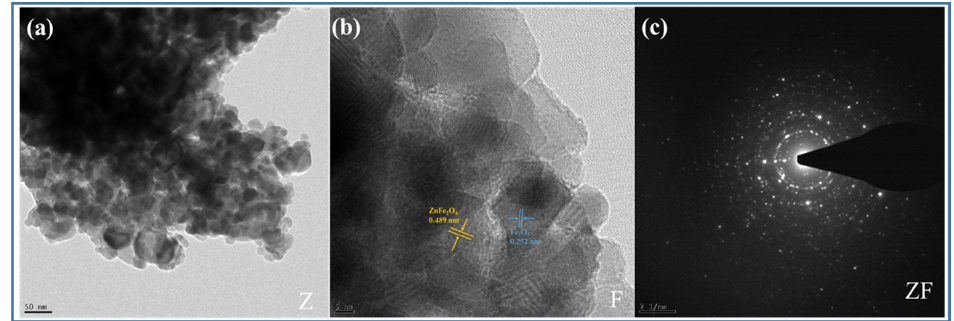
Figure 4. High resolution morphology images of ZnFe 2 O 4 -Fe 2 O 3 (ZF) nanostructures. The optical bandgap of the synthesized ZnFe 2 O 4 (Z), Fe 2 O 3 (F), and ZnFe 2 O 4 -Fe 2 O 3 (ZF) nanostructures were shown in Figure 5a. The estimated optical bandgap of 2.05, 1.97, and 2.01 eV was achieved for Z, F, and ZF nanostructures. These obtained bandgap values are well-matched with the reported literature [9,10]. The ZF structures changing the bandgap may be due to alteration of sizes and oxygen vacancies. Additionally, the ZF bandgap changes are due to the alteration of heterostructure band edges due to the static electric field-induced potential energy and strain-induced deformation potential.